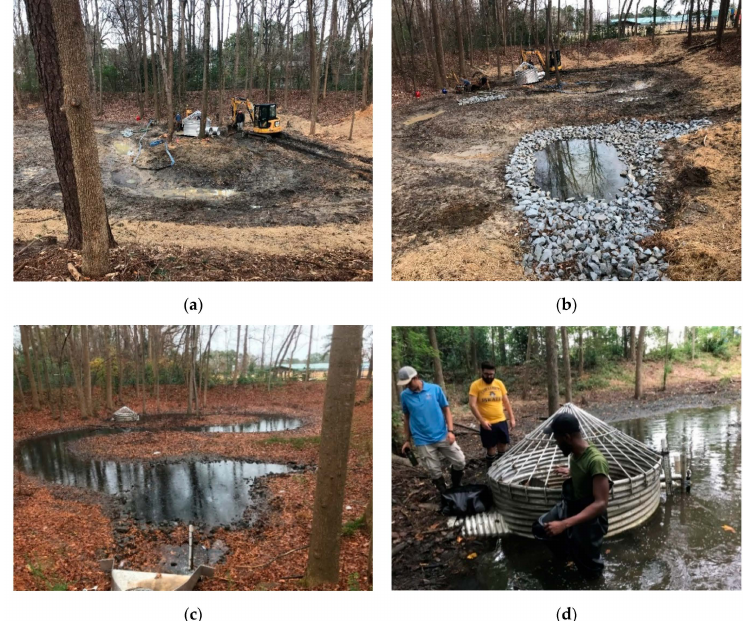
Figure 3. A new longer and meandering channel connecting the inlet to the outlet was created using an excavator ( a ). A forebay lined with rip rap was installed near the inlet ( b ). A new inlet structure with a flange was installed ( c ) and a new outlet structure with trash guard, and two draw downpipes were installed ( d ). Photographs were captured by the authors.